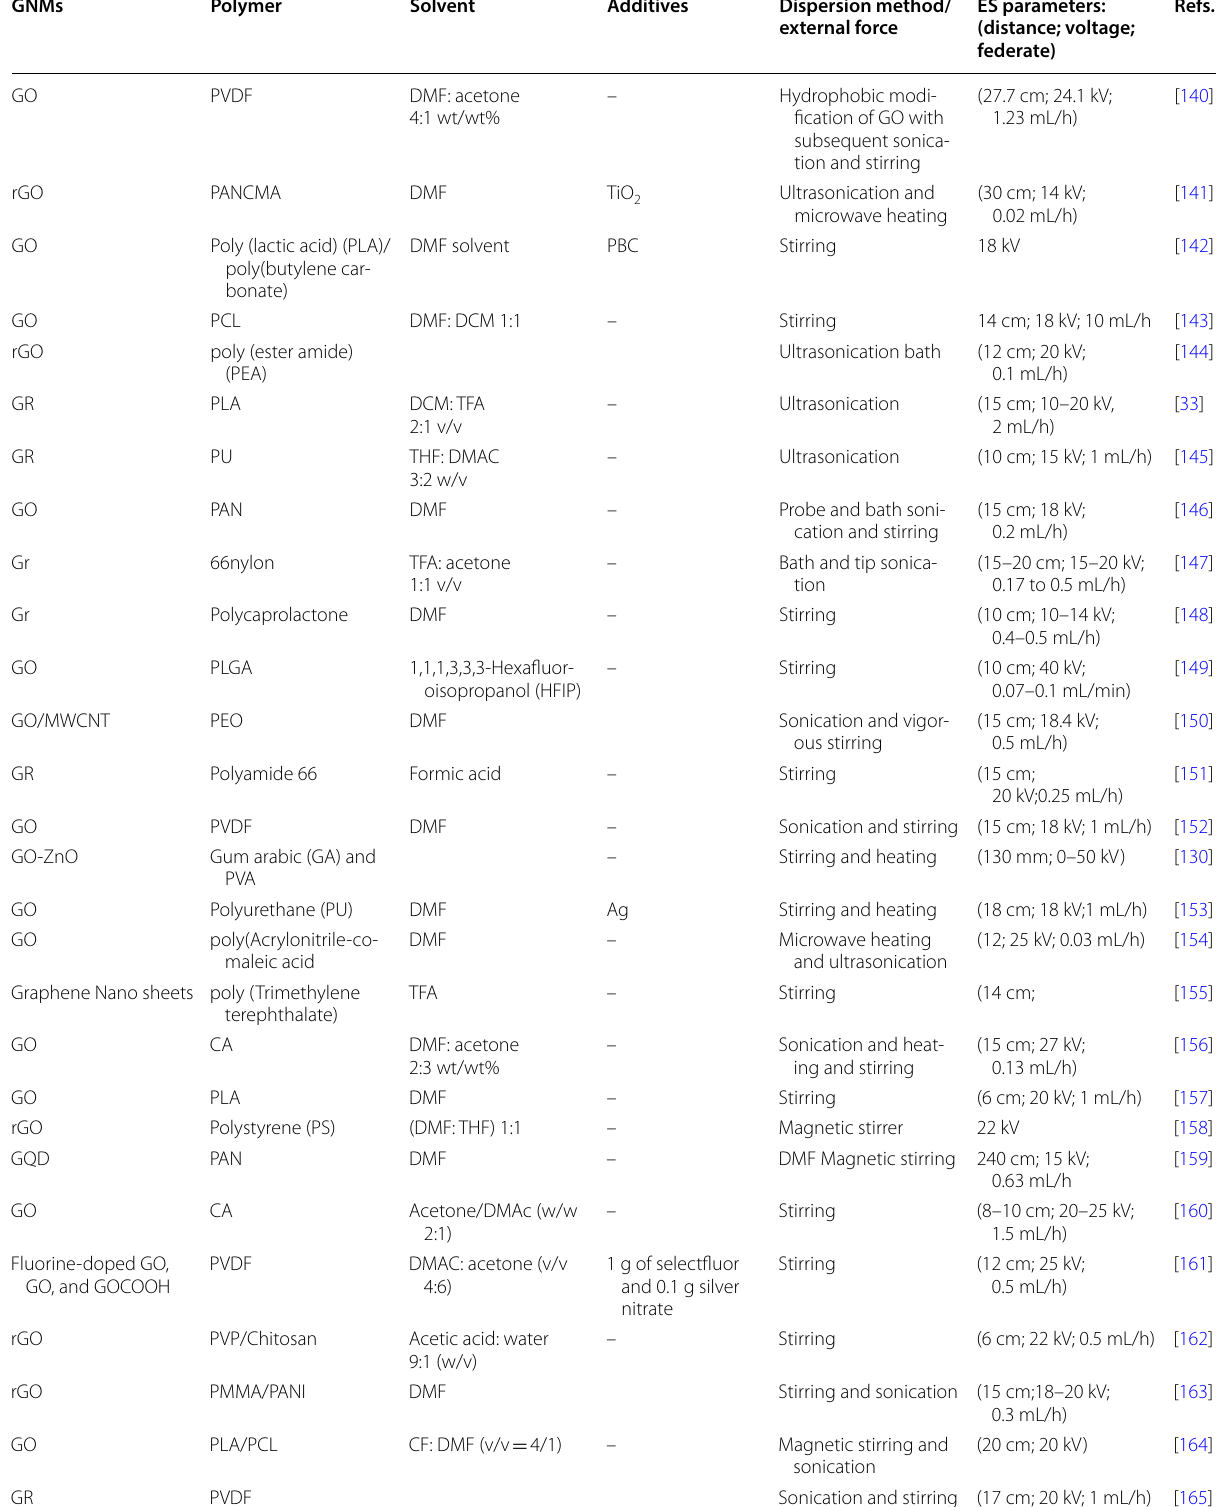
Table 1 Summary of recent significant works on electrospinning design of GNMs with polymer matrices using pre‑ processing